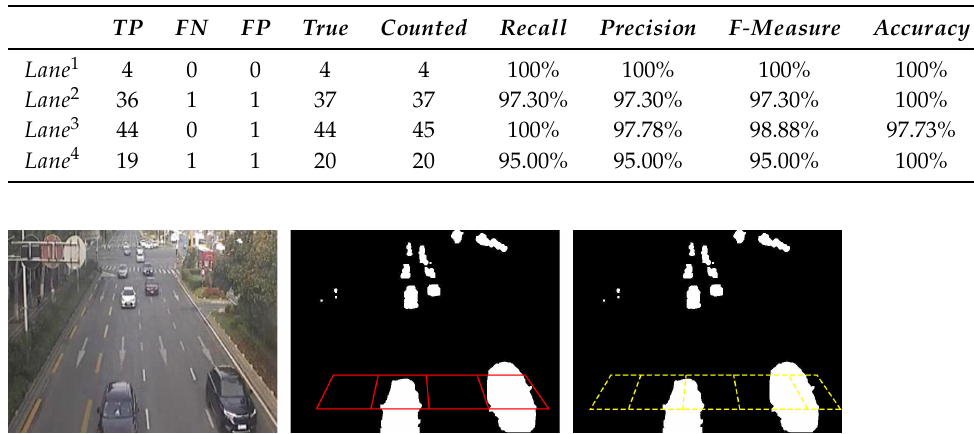
Figure 17. Example of the experimental results in Video III. Table 12. Experimental results of Video IV.